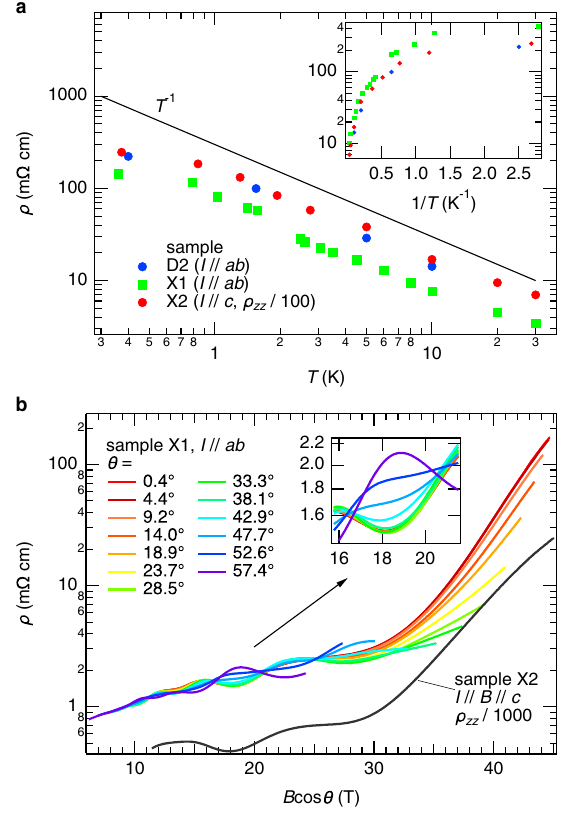
Fig. 4 Temperature and fi eld-direction dependences of the resistivity in CaFeAsF. a Resistivity at B = 45 T as a function of temperature. The fi eld direction is B ∥ c for samples D2 and X2 and θ = 9.2 ∘ for X1. The inset shows an Arrhenius plot of the same data. b Resistivity of sample X1 for various fi eld angles plotted against the c -axis component of the applied fi eld B cos θ . A blow-up of a region near B = 19 T is shown in the inset. Note that the spin reduction factor R s changes sign at θ ≈ 50 ∘ for both α and β oscillations (see text for explanation). The c -axis resistivity for B ∥ c in sample X2 is also shown in the main